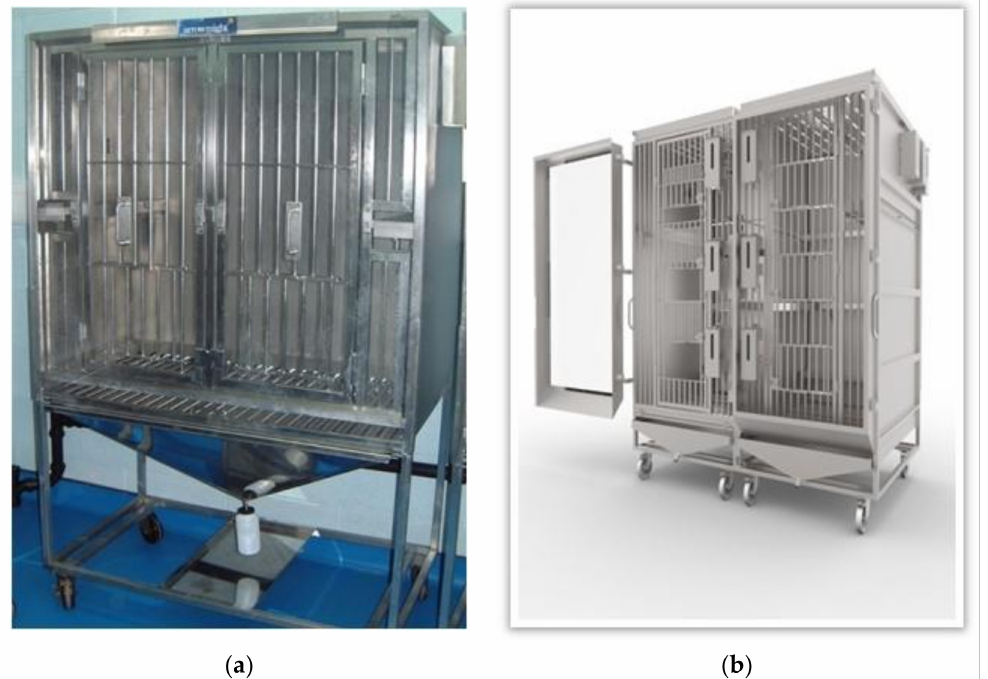
Figure 2. Metabolism cages for single ( a ) and group ( b ) housing of NHPs.